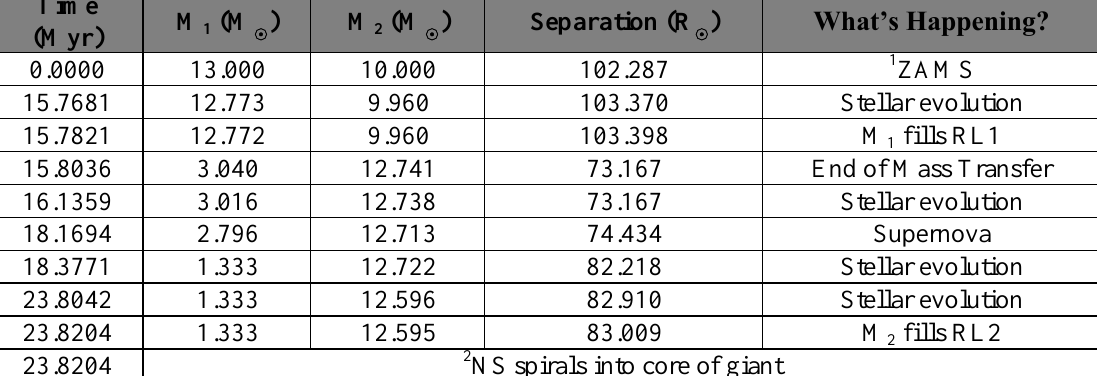
,including Mass transfer phase.[10] 